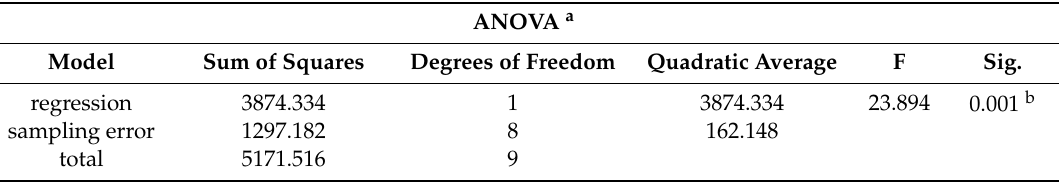
Table 7. Analysis of variance: Wheel-tracking test and first modulus of the plate bearing test. ANOVA a Model Sum of Squares Degrees of Freedom Quadratic Average F Sig.